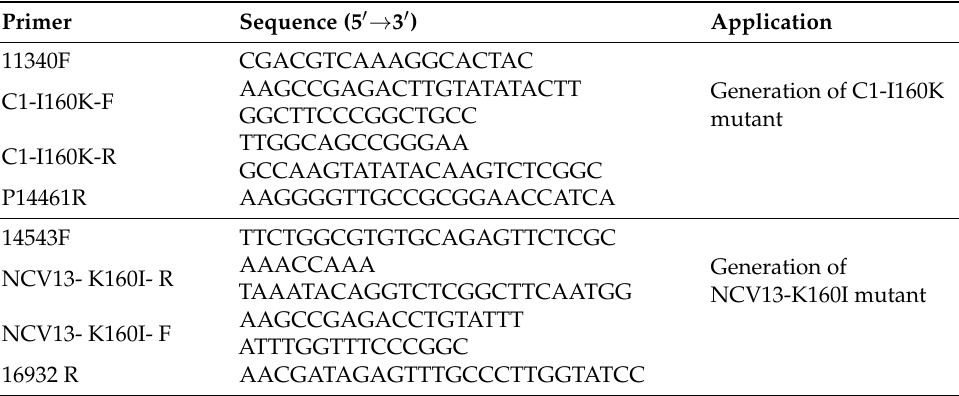
Table 2. Oligonucleotide primers used for the site-directed mutagenesis. Primer